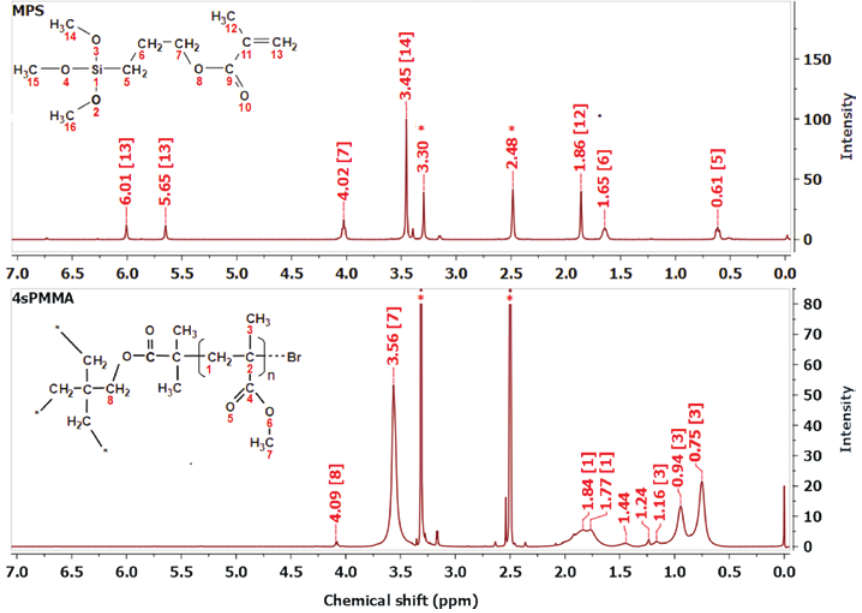
(*, residual solvent). 6